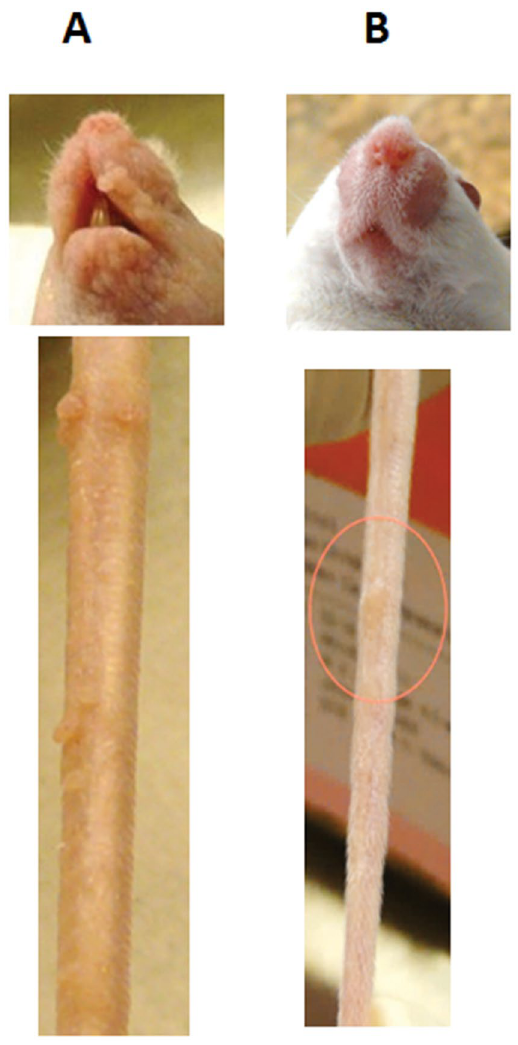
Figure 4. NU/J homozygotes and heterozygotes displayed differential response to infections at cutaneous sites. Four homozygous inbred NU/J nude mice and four heterozygous inbred hairy NU/J mice were tested for infection at cutaneous sites (tail and muzzle). Lesions were detected at most tail and muzzle sites in the homozygotes (a typical lesion shown in ( A ), but only a single tail lesion was observed in one of four heterozygotes and that lesion later regressed ( B ). No muzzle lesions were observed in the